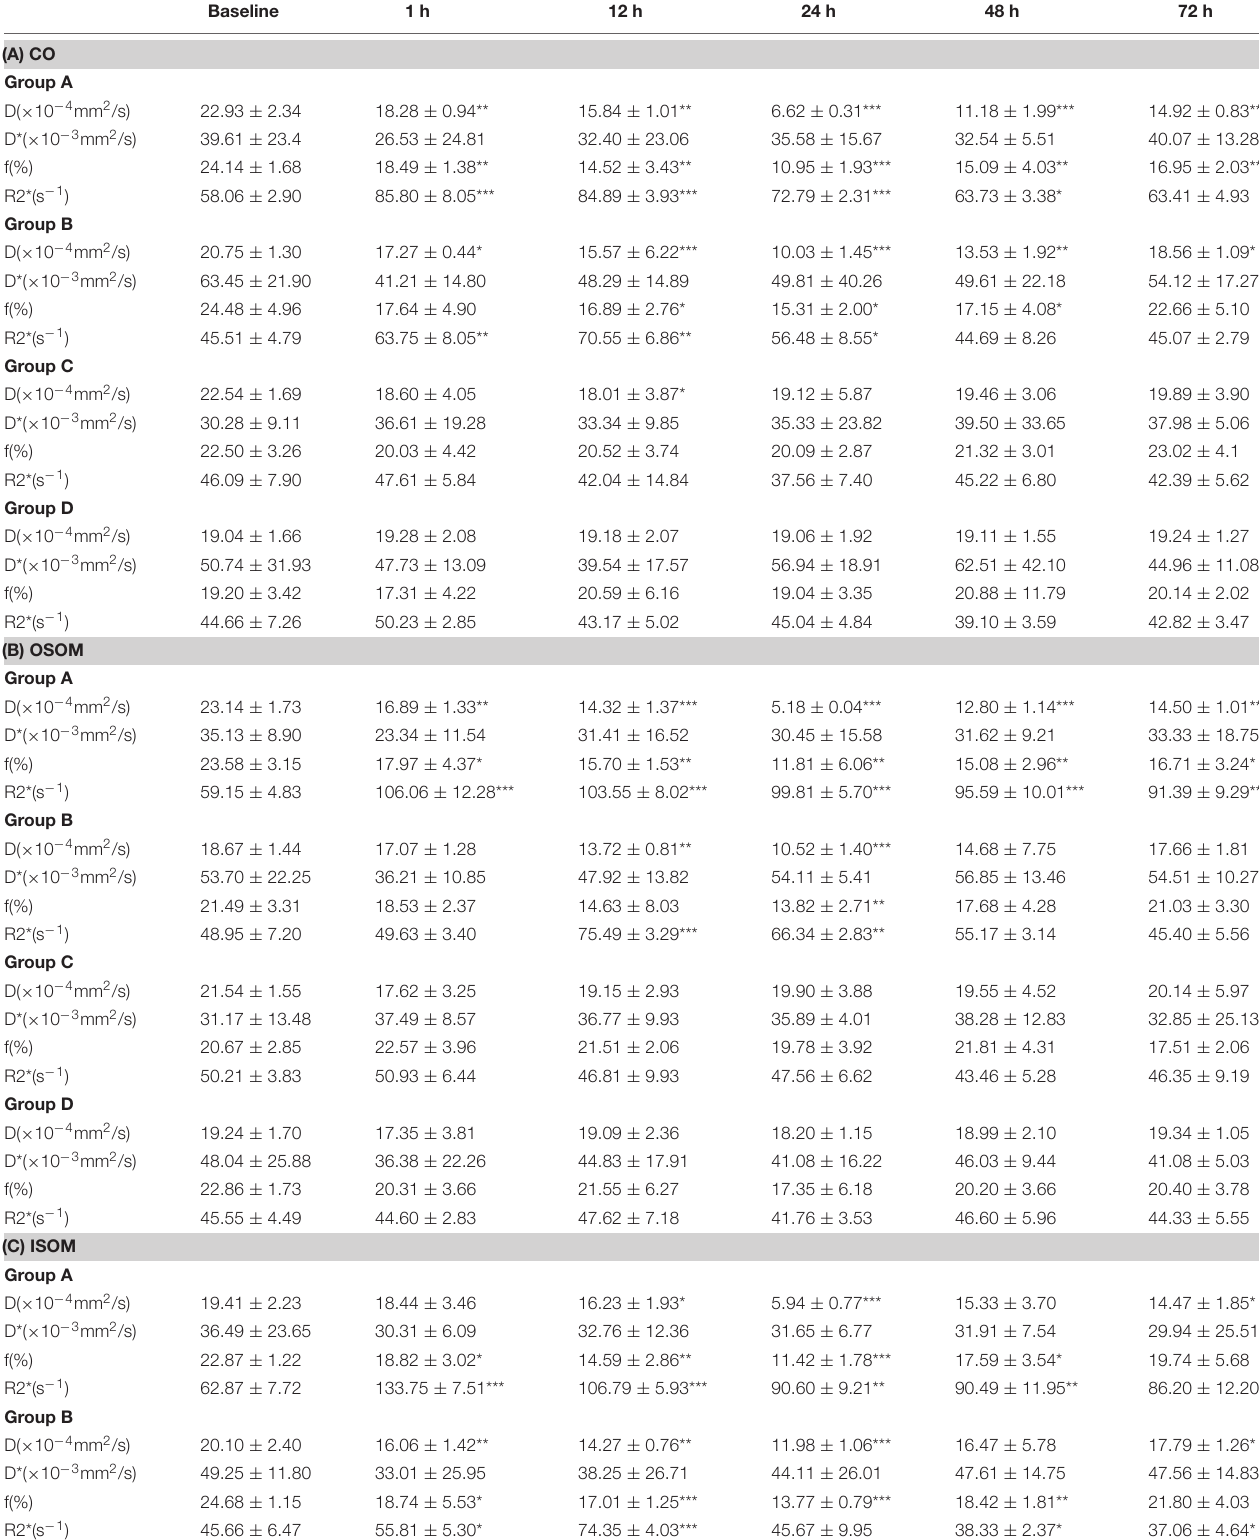
TABLE 2 | Values of parametric image from four groups of CO, OSOM, and ISOM.